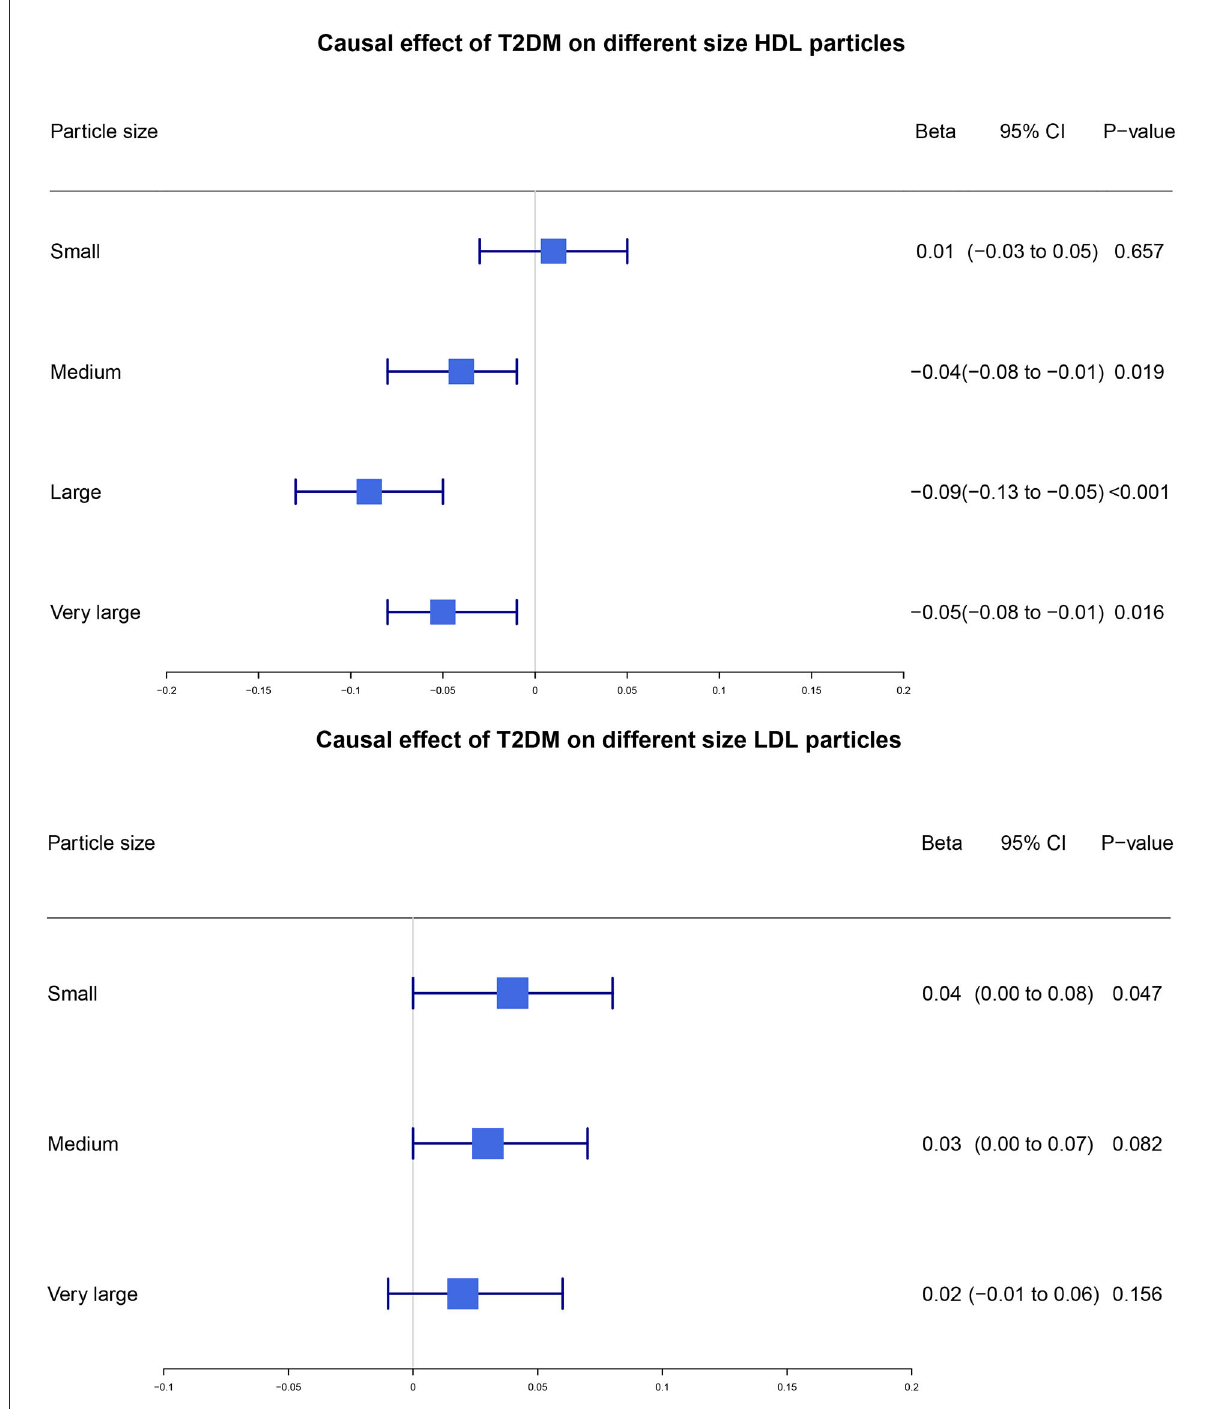
FIGURE4 Estimate of the causal effect of T2DM on different sizes of HDL and LDL particles. We used the two-sample MR method to estimate the potential causal effect of T2DM on different sizes of HDL and LDL particles. T2DM, type 2 diabetes mellitus; HDL, high-density lipoprotein; LDL, low-density lipoprotein; CI, confidence